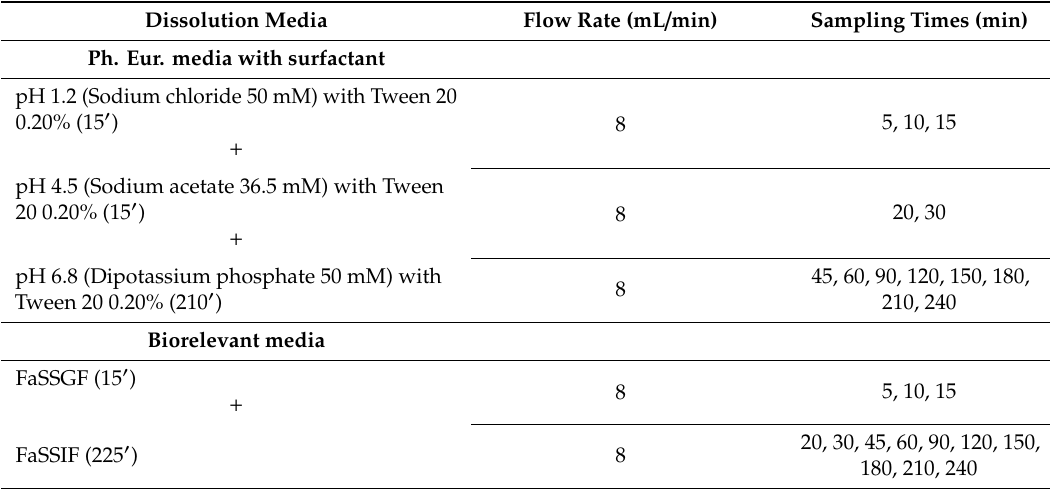
Table 3. Characteristics of the dissolution experiments conducted in USP IV (Dissolution media, flow rate and sampling